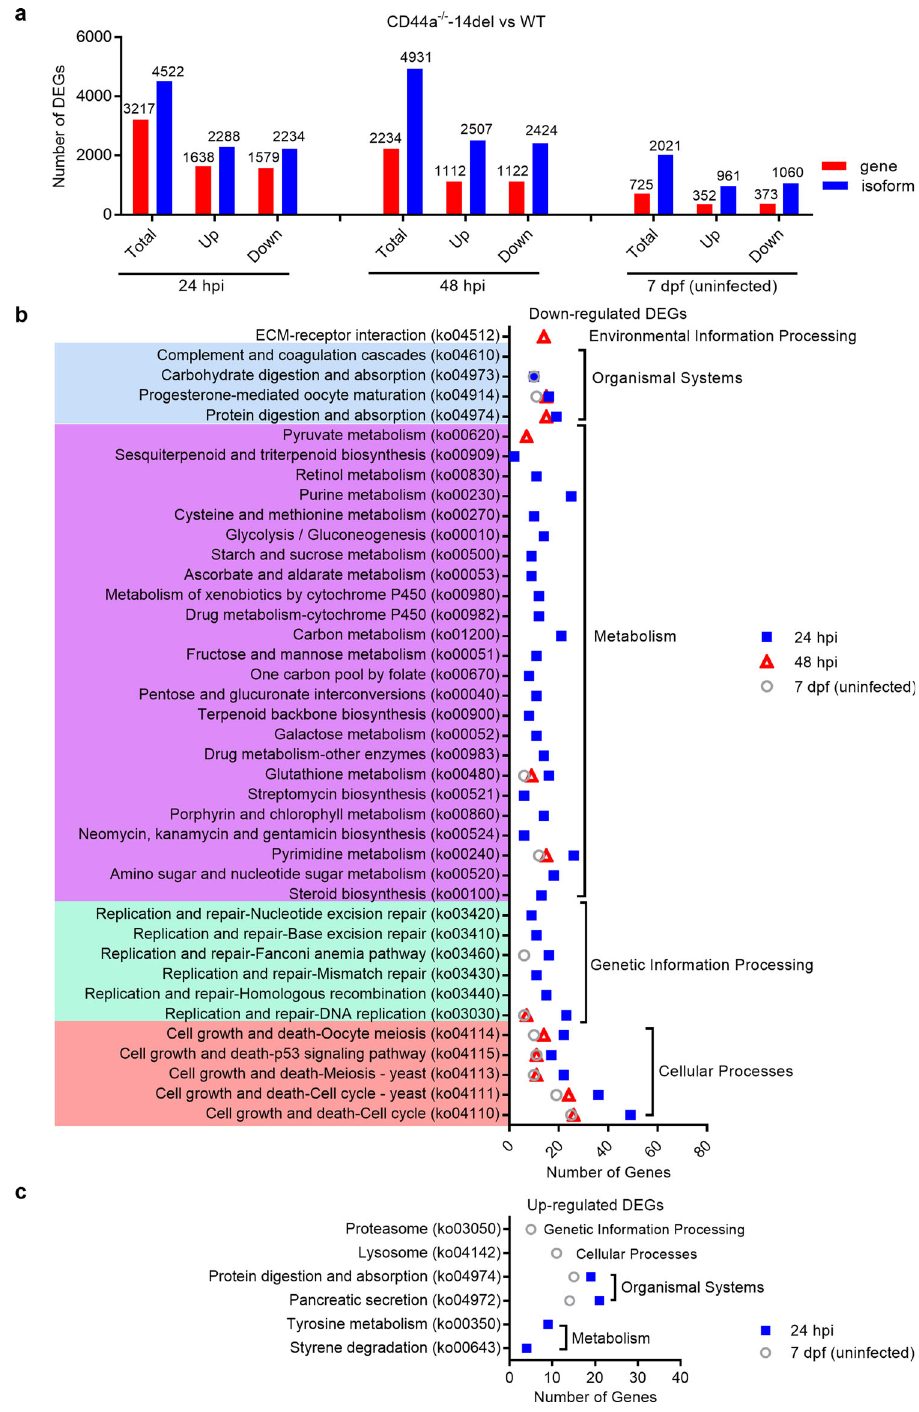
Fig. 3 CD44a de fi ciency impairs cell growth and death pathways. a The numbers of differentially expressed genes and isoforms at 24 hpi, 48hpi and 7 dpf from the WT and CD44a − / − -14del zebra fi sh larvae with or without the infection of E. piscicida . b KEGG enrichment analysis of the down-regulated DEGs at 24hpi, 48hpi and 7 dpf from the WT and CD44a − / − -14del zebra fi sh larvae with or without the infection of E. piscicida . c KEGG enrichment analysis of the up- regulated DEGs at 24 hpi, 48 hpi and 7 dpf from the WT and CD44a − / − -14del zebra fi sh larvae with or without the infection of E. piscicida